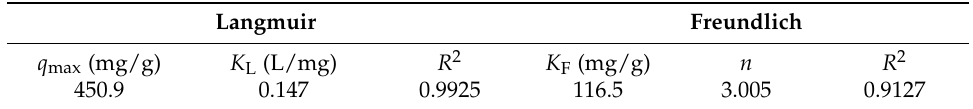
Figure 8. Comparison experimental data and two isotherm equations for Pb 2+ adsorption on the as-prepared GO at 298 K. Table 1. Parameters of Langmuir and Freundlich adsorption isotherm models for Pb 2+ on as-prepared GO.